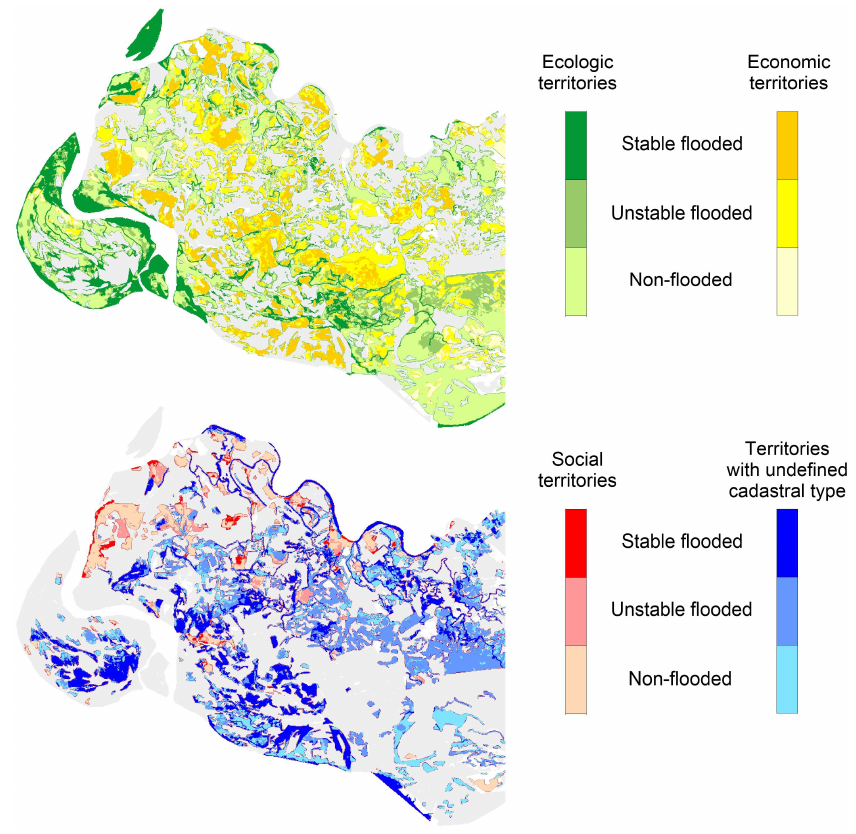
Figure 14. Maps of the complex structure for the northern part of the VAF in